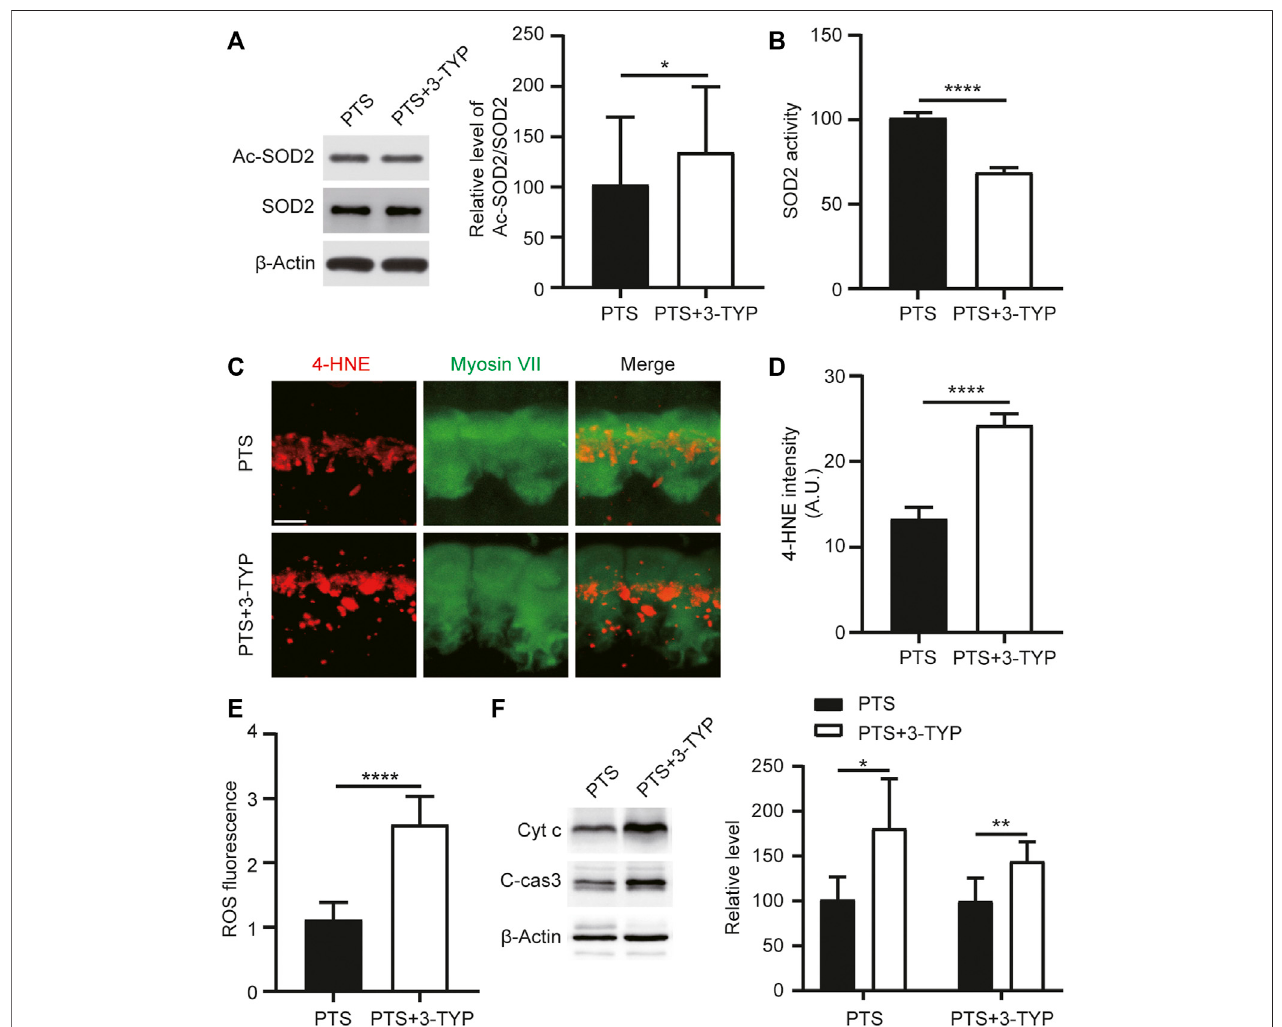
FIGURE5 | Effect of3-TYP on SOD2acetylation, ROS and apoptosis-related protein levels inthe hair cells ofmice inthe PTSgroup. (A) Westernblotting showing theeffectof3-TYPonSOD2acetylationlevelsinmiceinthePTSgroup.TheresultsareexpressedasthepercentageofthePTSgroup,whichwassetto100%( n (cid:1) 3per group). (B) Effect of 3-TYP on SOD2 activity in the cochlear cells of PTS mice ( n (cid:1) 10 per group). (C) Immunohistochemical staining showing changes in 4-HNE fl uorescence intensity in IHCs. (D) Quanti fi cation of 4-HNE fl uorescence intensity ( n (cid:1) 6 per group). (E) Detection of ROS levels in the cochlear cells ( n (cid:1) 10 per group). (F) WBshowingchangesincaspase3andCytochromecexpression( n (cid:1) 6pergroup).ROS,reactiveoxygenspecies;PTS,permanentthresholdshift;IHC,inner hair cell. * p < 0.05; **** p < 0.0001. Scale bars: C, 5 μ